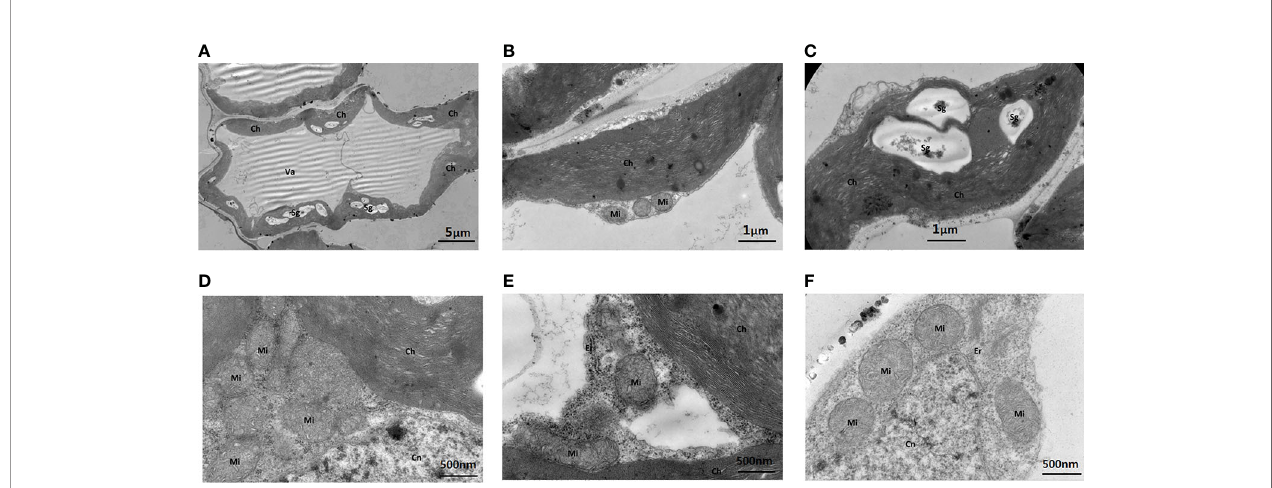
FIGURE 7 | Effect of solid MS culture medium with Na 2 WO 4 on cell morphology and ultrastructure in leaf of strawberry seedlings. (A) The abnormally shaped cell with organelles. (B) The irregular chloroplast of seeding under Na 2 WO 4 condition. (C) The poorly developed chloroplast with Sgs. (D) Mi, Cn and Ch in the cell (E) Mi, Er, Cn and Ch in the cell. (F) Mi, Er, and Cn in the cell. Ch, chloroplast; Cn, cell nucleus; Er, endoplasmic reticulum; Mi, mitochondria; Va, vacuole; Sg, starch grain.